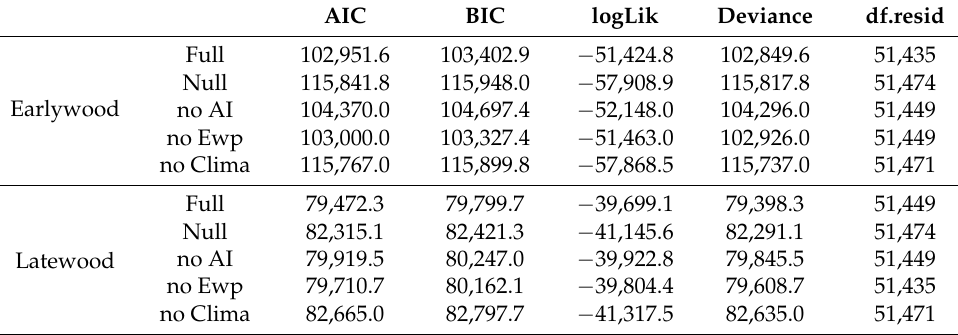
Table 2. Accuracy assessment of the models. Goodness-of-fit measures: AIC (Akaike